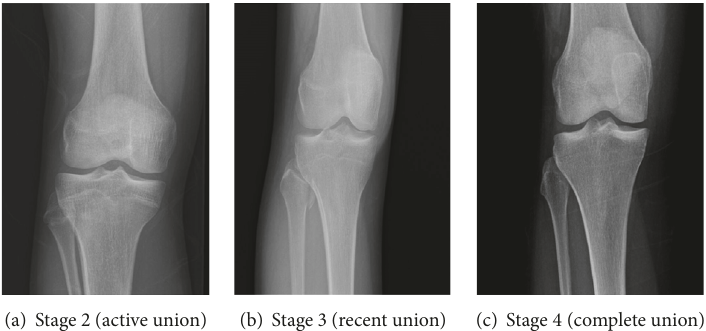
Figure 2: Radiographic images of knee joint showing stage 2 labeled as (a) and stage 3 labeled as (b) and stage 4 labeled as (c).